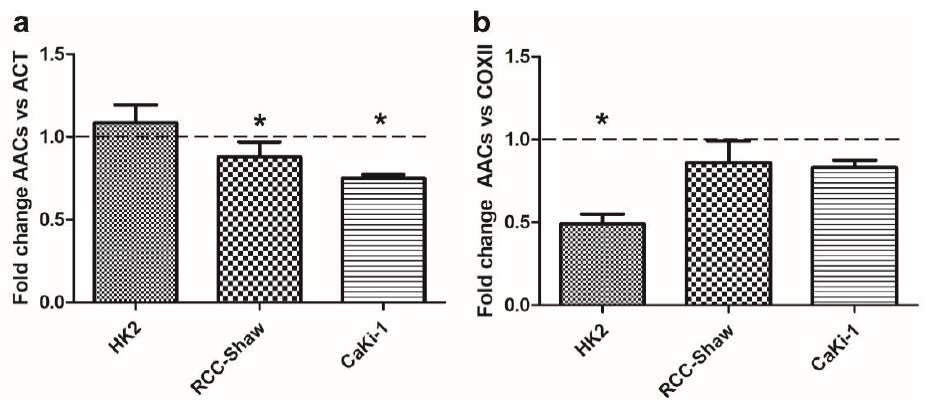
Figure 3. Ratio of AACs protein content estimated through WB in HK2, RCC-Shaw, and CaKi-1 cells grown in serum-free medium versus complete medium conditions with respect to actin content (panel a ) or COXII content (panel b ). Data are presented as mean + SE of at least three independent experiments. * p < 0.05; nonparametric Wilcoxon two-tailed test between starved and physiological conditions. For a representative WB see Supplementary Figure S3. The protein concentration from extraction assays was reported in Supplementary Table S2.